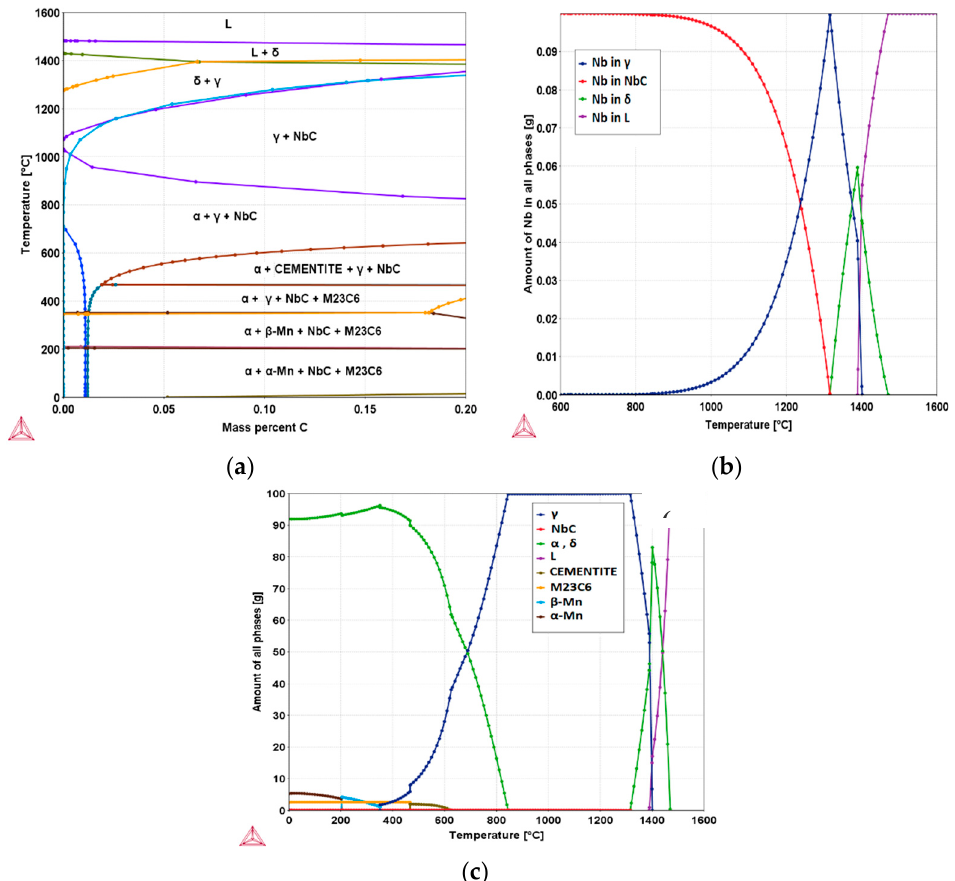
Figure 1. Simulated diagrams obtained by using Thermo-Calc software: ( a ) Pseudo-binary phase diagram, ( b ) amount of niobium in the phases as a function of temperature, and ( c ) amount of phases as a function of temperature.